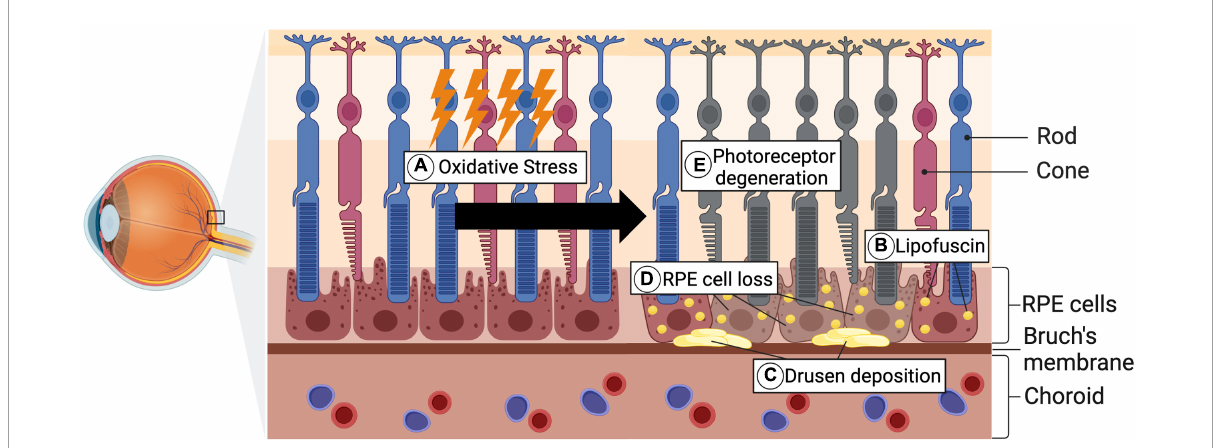
FIGURE4 Pathological hallmarks of AMD pathogenesis. (A) As a consequence of genetic predispositions, environmental factors, as well as aging, oxidative stress accumulates. (B,C) Lipofuscin, which is composed of lipid- and protein residues, forms under increased oxidative stress levels and further accumulates in RPE cells. Alongside the lipofuscin, Drusen depositions, consisting of extracellular material, form in the area of Bruch’s membrane. (D) Through the progredient accumulation of these depositions, the RPE cell death is subsequently triggered. (E) Secondary this then leads to photoreceptor degeneration and occurrence of visual impairments (Created with